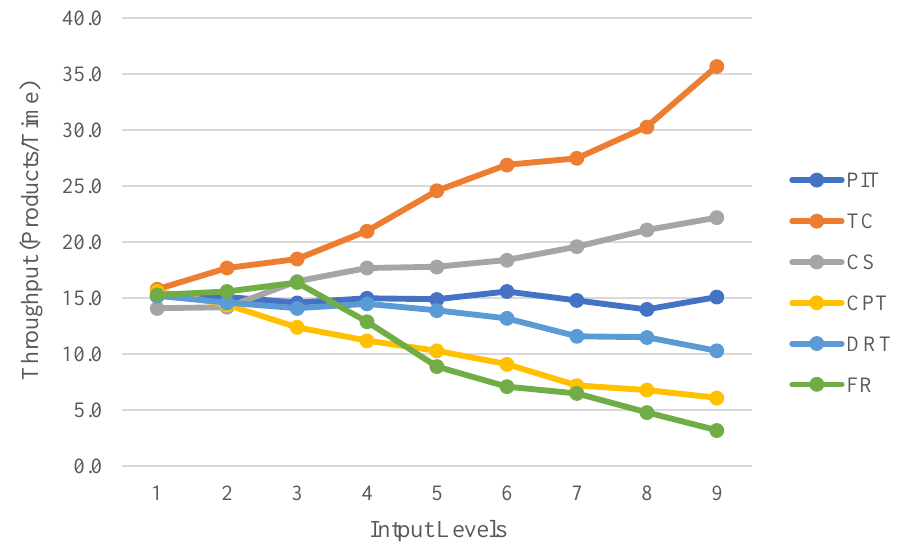
FR0.050.0100.0 Figure 9. Variation in throughput at different input factors